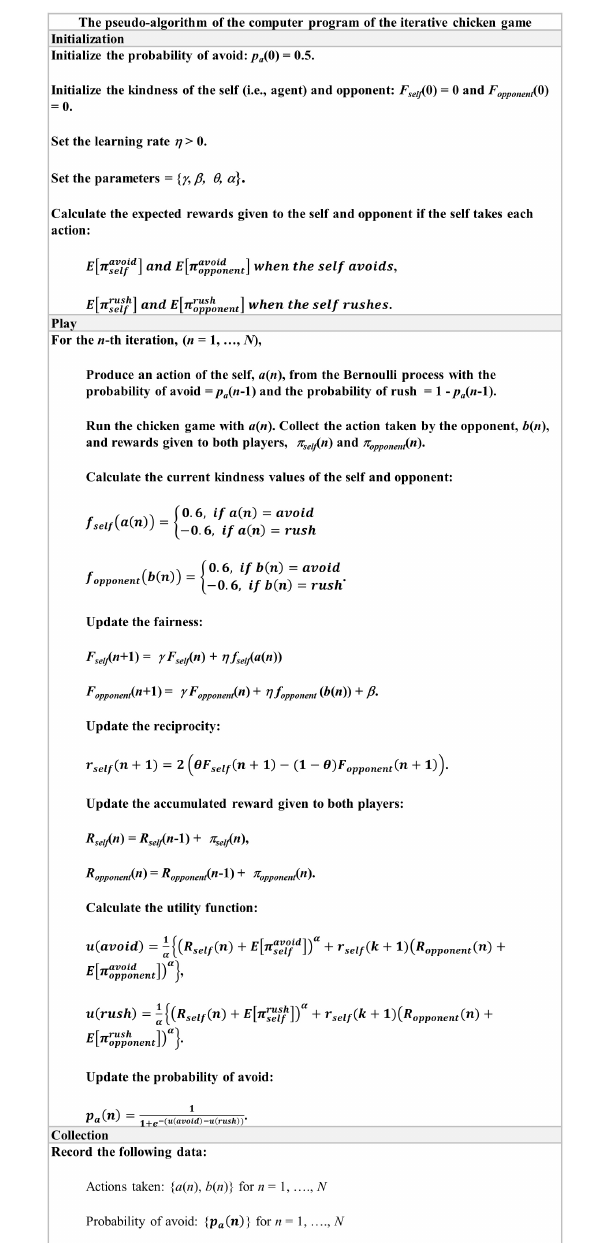
FIGURE 1 | The pseudo-algorithm of the computer program to run the iterative chicken game with an artificial agent making a decision based on the self-concept fairness model (see the text). Here, the self indicates the artificial agent and the opponent can be any player.